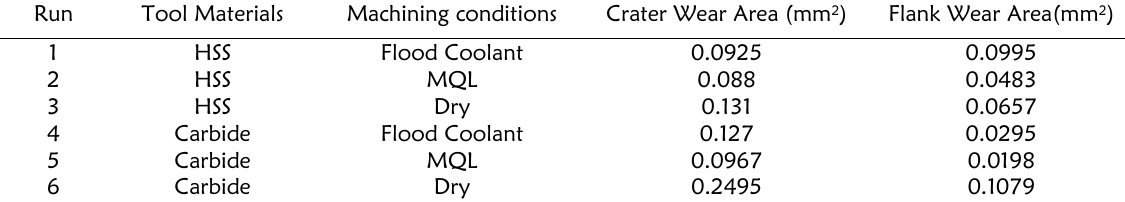
Table 4: Results comparison of crater wear and flank